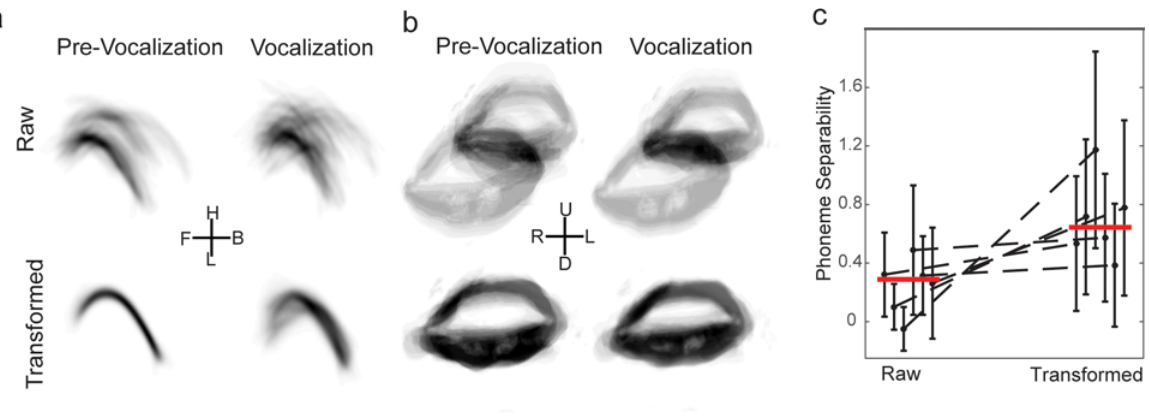
Fig 2. Utterance-to-utterance registration of vocal tract data. a) All tongue data from one subject. Left, top: overlay of raw tongue data during the pre- vocalization period for all trials; left, bottom: overlay of the same data after applying the optimal transformation. Right, top: overlay of raw tongue data during vocalization for all trials; right, bottom: overlay of the same data after applying the transformation from the pre-vocalization time. b) All lip data from one subject. Left, top: overlay of raw lip data during the pre-vocalization period for all trials; left, bottom: overlay of the same data after applying the optimal transformation. Right, top: overlay of raw lip data during vocalization for all trials; right, bottom: overlay of the same data after applying the transformation from the pre-vocalization time. c) Quantification of efficacy of applying transform from pre-vocalization data to vocalization times: enhanced separability. We calculated the separability between vowels based on articulatory features during vocalization before (raw) and after (transformed) applying the transformation optimized for the pre-vocalization time. The transformed data consistently had increased separability. Black points: mean ± s.d. across vowel comparisons for a subject, red line: median across